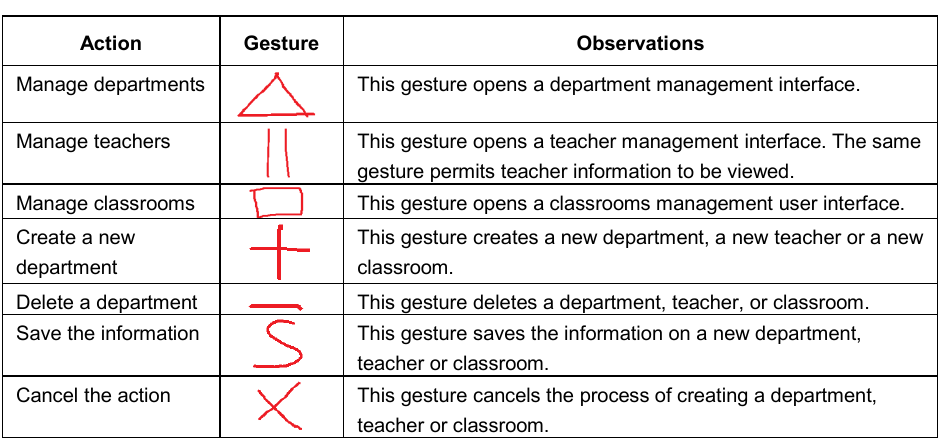
Table 1. Platform-independent gesture catalogue definition